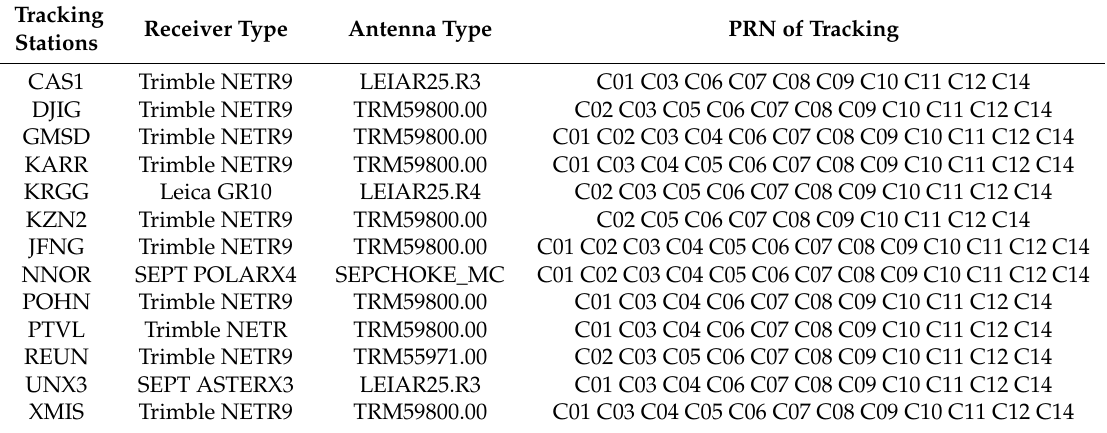
Table 1. MGEX tracking-station information in this